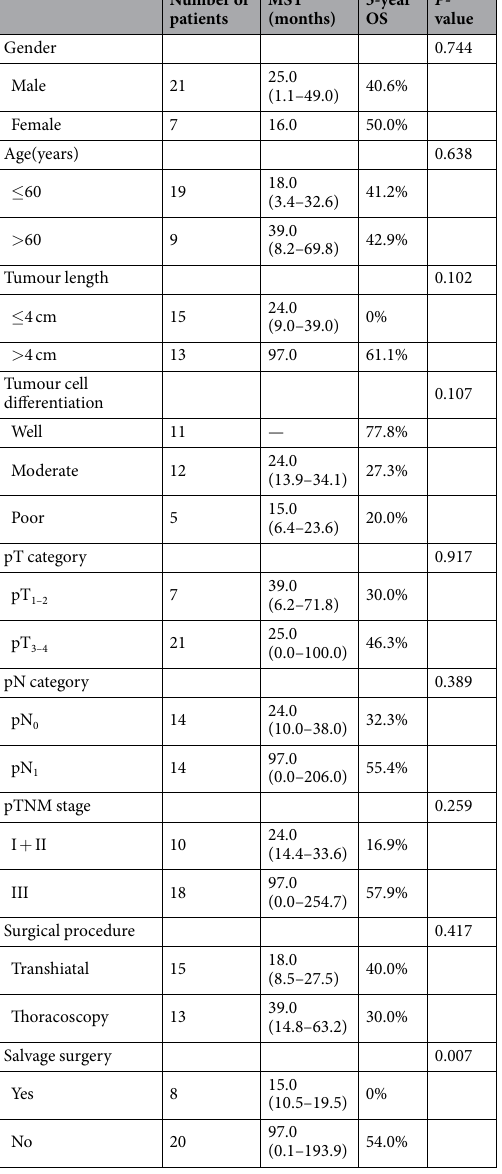
Table 1. Univariate analysis of the prognosis of 28 patients with cervical oesophageal cancer who underwent surgery. Abbreviations: MST, median survival time; OS, overall survival; pT category, pathologic T category; pN category, pathologic N category; and pTNM stage, pathologic TNM stage. The TNM stage was based on the sixth edition of the American Joint Committee on Cancer staging system for oesophageal cancer. Surgical procedures were subdivided into two groups: transhiatal oesophagectomy without thoracotomy and thoracoscopic